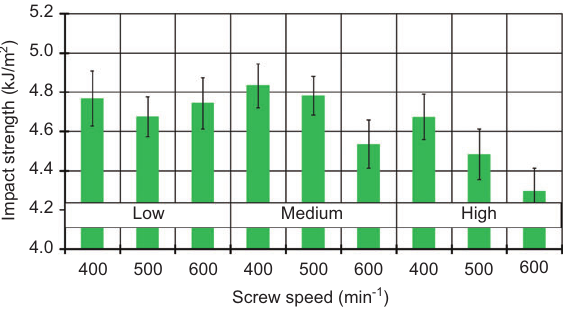
Figure 6 Notched impact strength for different screw configura- tions at 400 min -1 , 500 min -1 , and 600 min -1 .